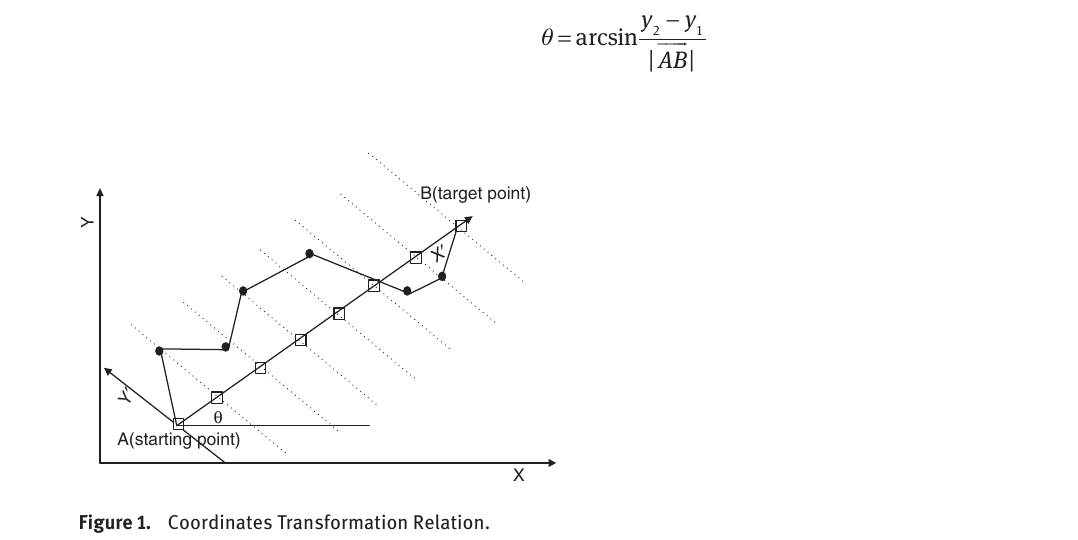
Figure 1. Coordinates Transformation